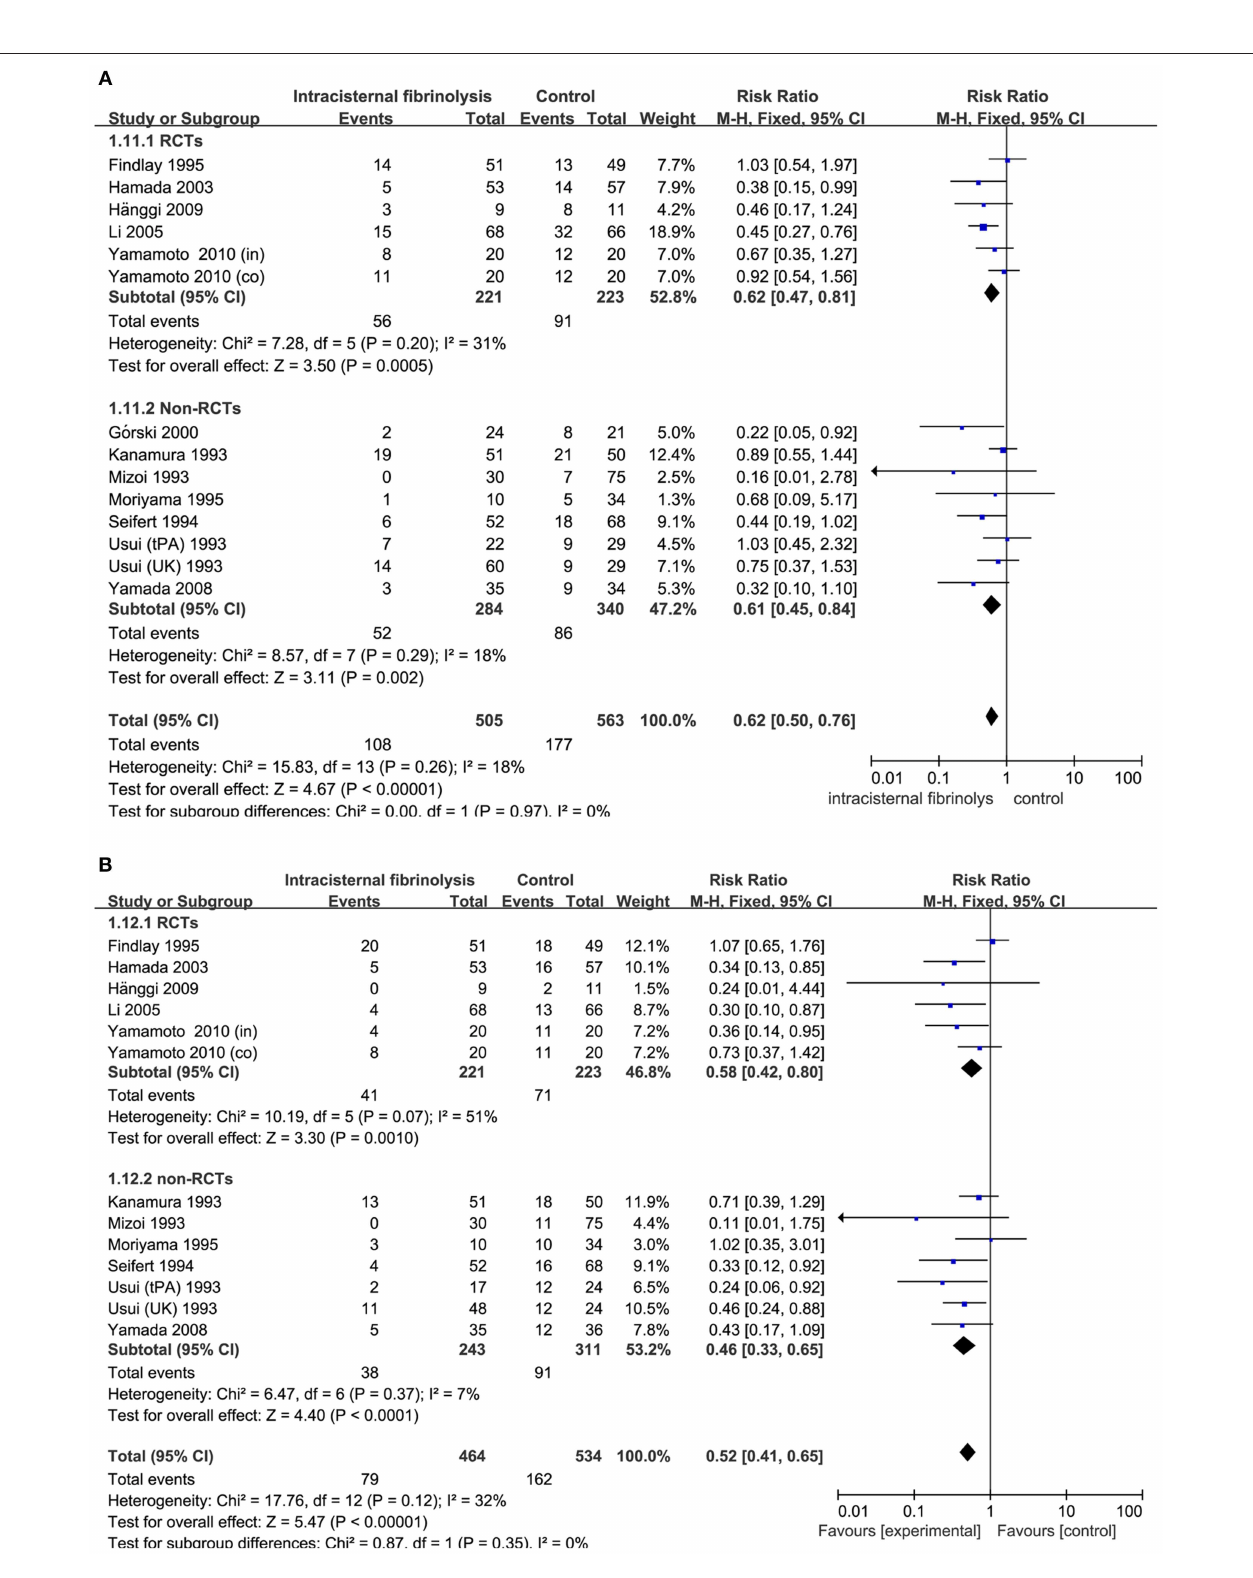
FIGURE 3 | Meta-analysis of associations between intracisternal fibrinolysis and the risk of poor neurologic recovery (A) or the incidence of DIND (B) in patients with aSAH. aSAH, aneurysmal subarachnoid hemorrhage; CI, confidence interval; DIND, delayed ischemic neurologic deficit; M-H, Mantel-Haenszel method; RCTs, randomized controlled